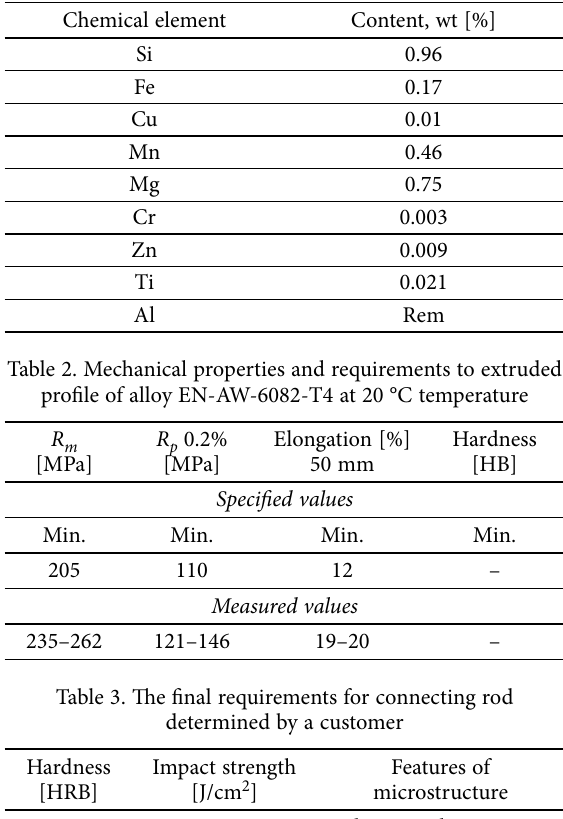
Table 1. Chemical composition of EN-AW-6082-T4 certified